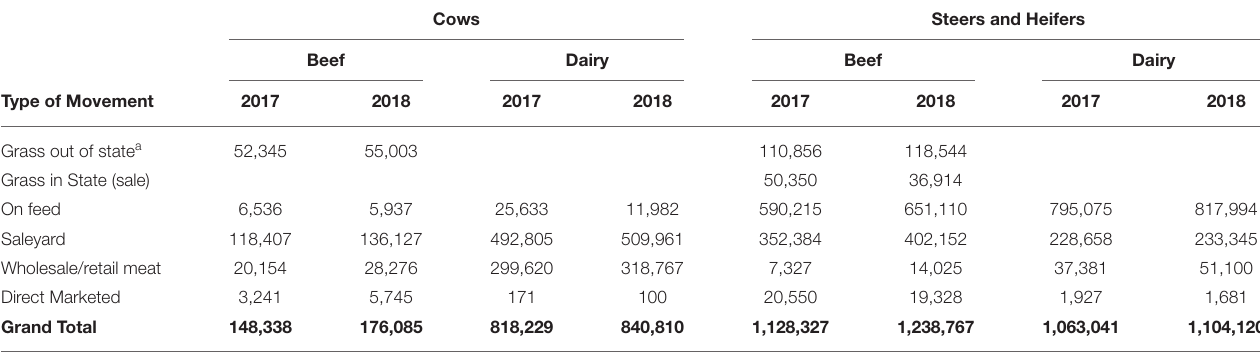
TABLE 2 | Beef and dairy cattle contributing to beef production in California by age class for 2017 and 2018 based on movement from grazing lands and